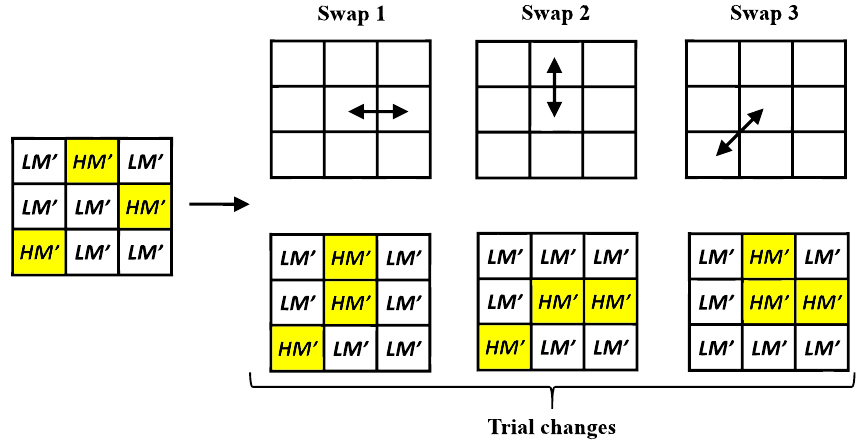
Figure 3. Illustration of the Direct Binary Search (DBS) swap operator, which is used in the quality improvement phase.